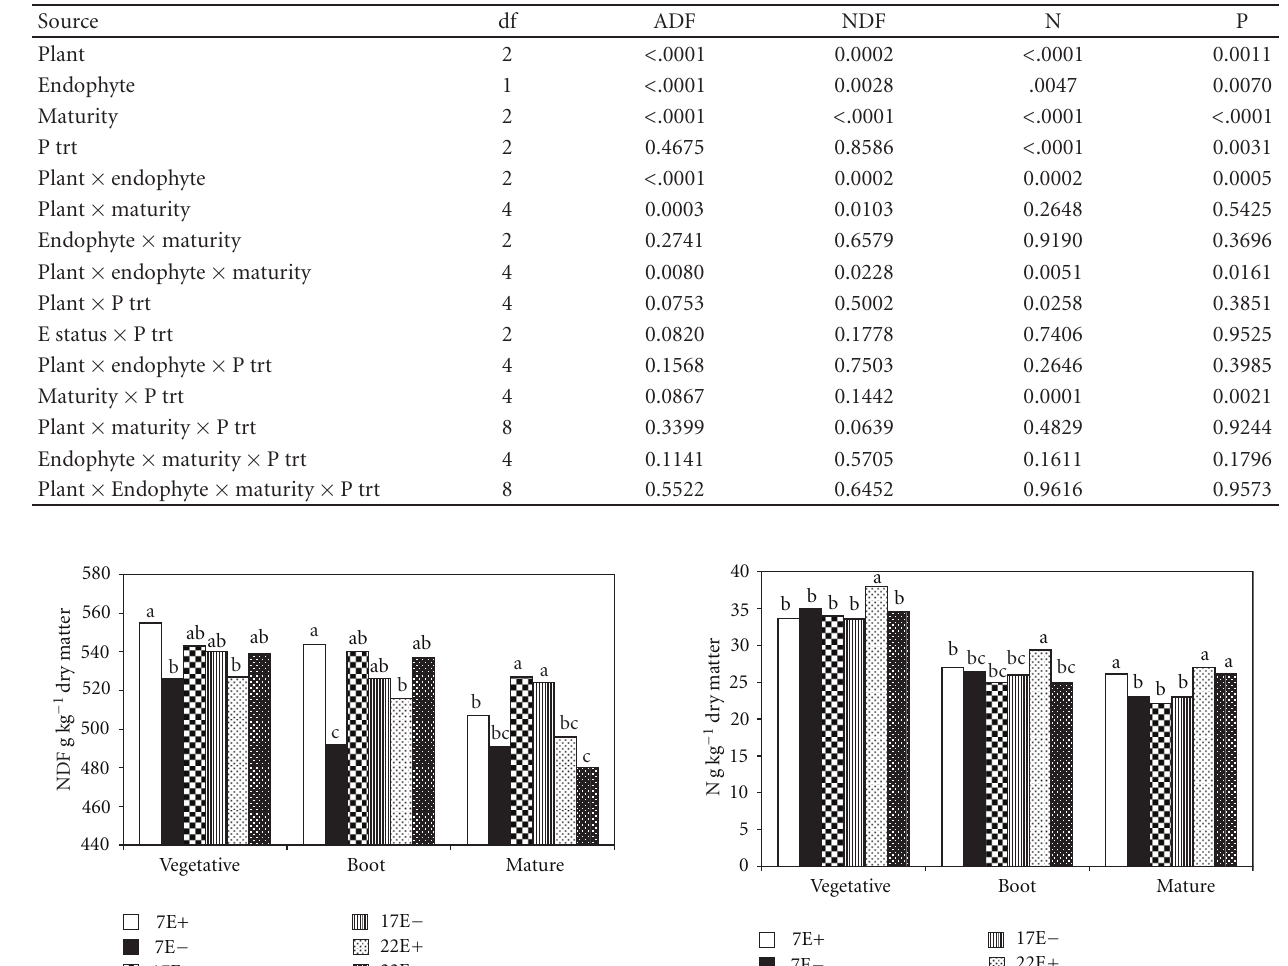
Table 4: Analysis of variance P -values for dry matter concentrations of ADF, NDF, N, and P content of endophyte infected and free tall fescue clones in the greenhouse study.